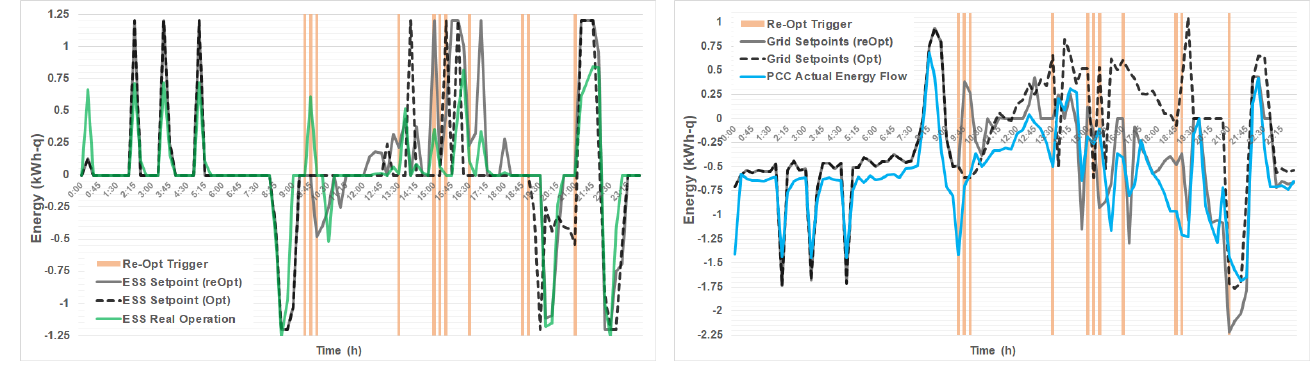
Figure 7. Scenario B—Re-Optimisation mode on 22/7: BESS/grid operation.